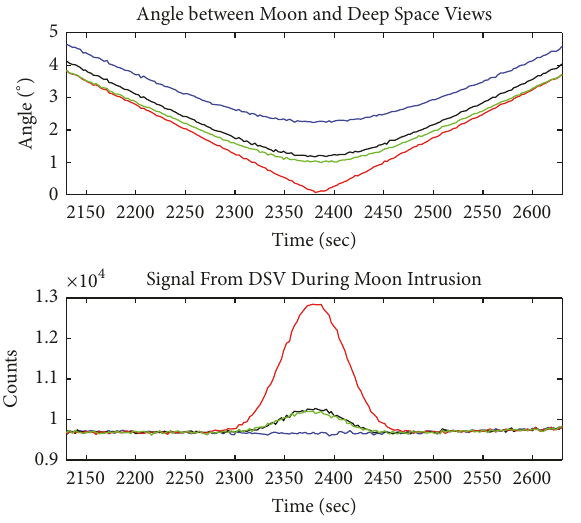
Figure 3: Moon intrusion event in deep space view 3 on 29 September 2018 (last Moon intrusion considered), with channel H1 of MHS on NOAA-18; blue dots: measured signal from each scan; red line: Gaussian fit to the measured points. The “light” curve resembles very closely a